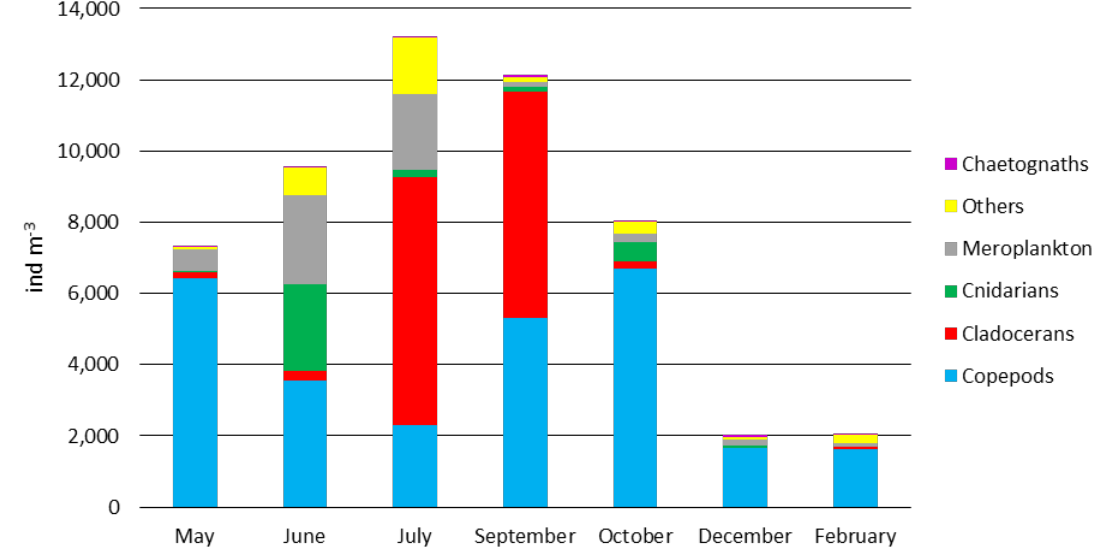
Figure 3. Composition and abundance (ind. m − 3 ) of mesozooplanktonic taxa in the field during the sampling periods.